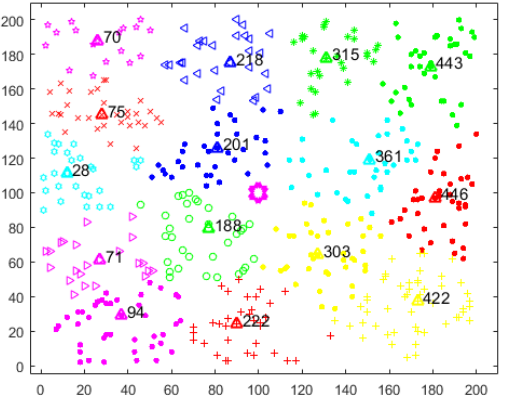
Figure 4. K-Means clustering in the PECR algorithm.